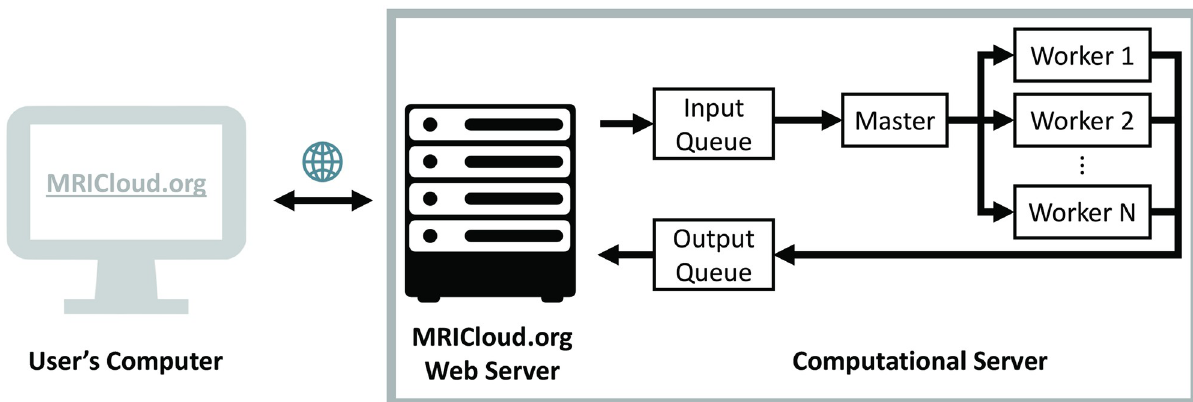
Fig 1. Illustration of the general architecture of the CVR-MRICloud platform.